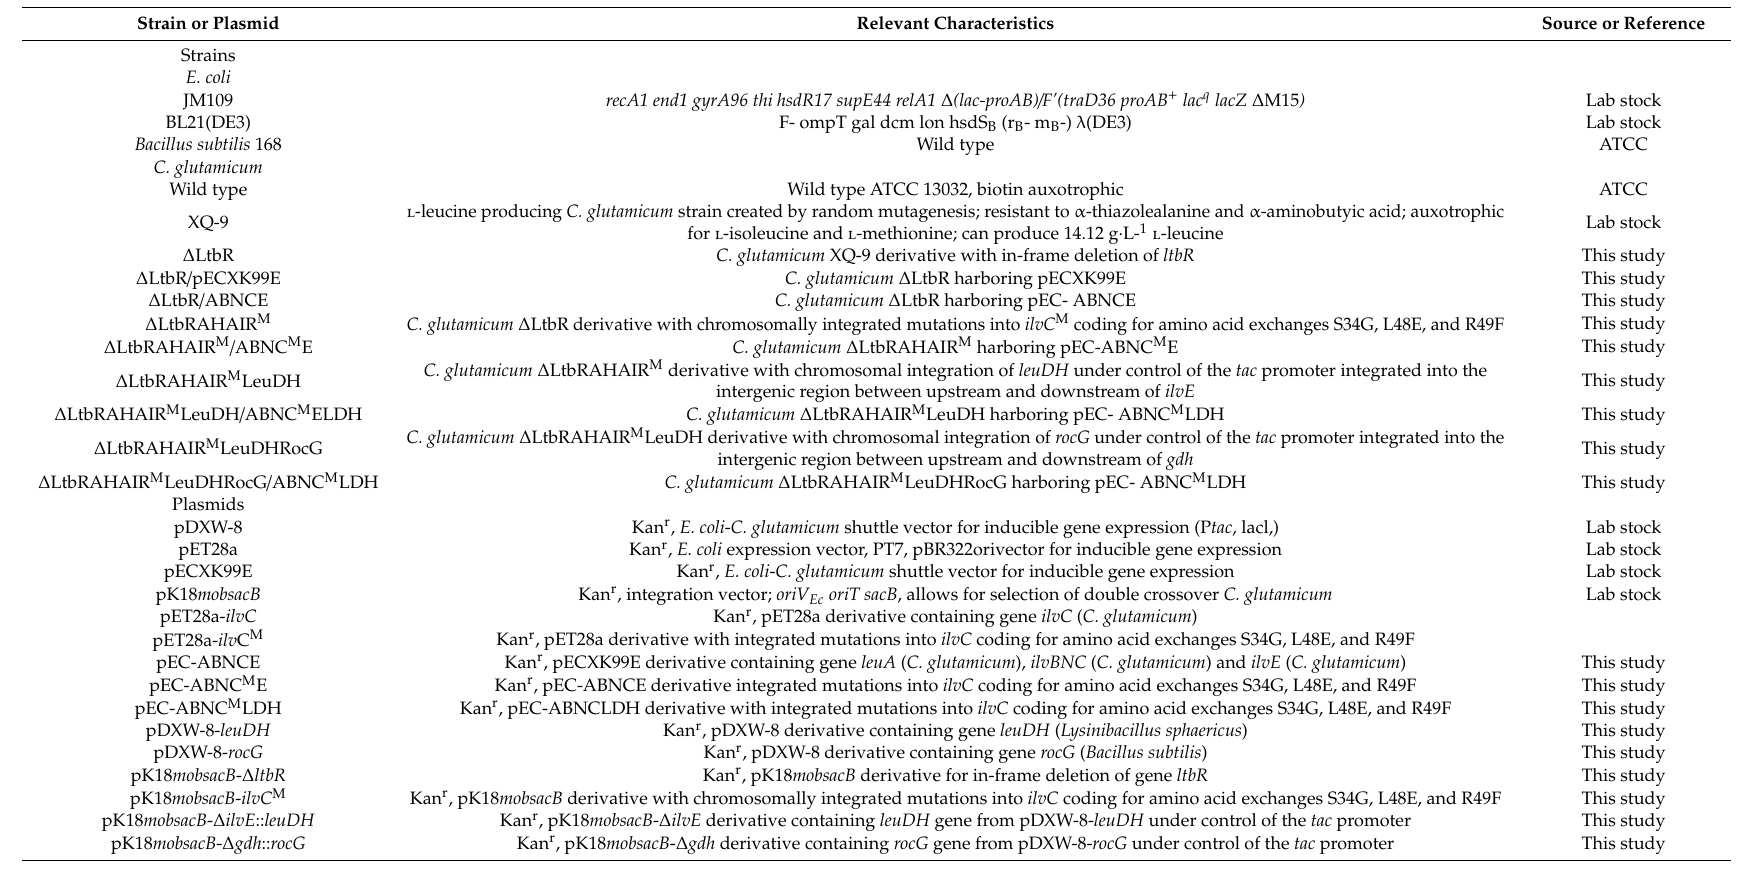
Table 3. Bacterial strains and plasmids used in this